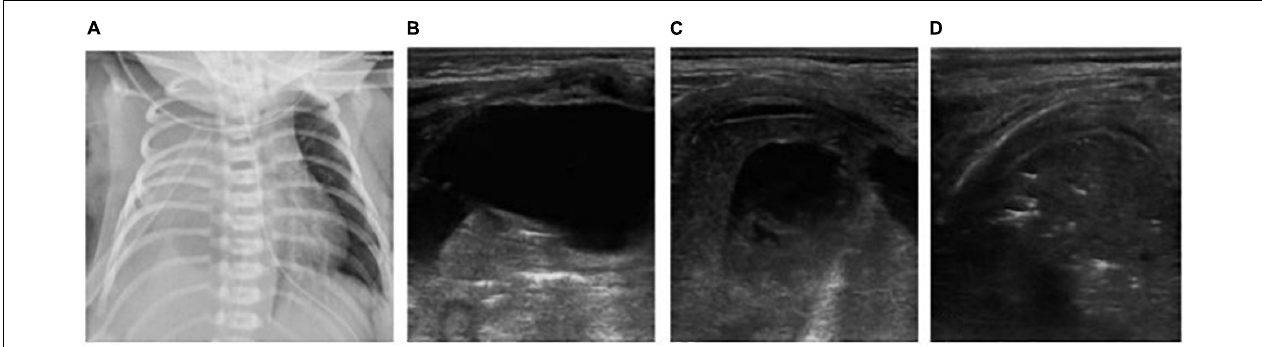
FIGURE 3 | The patient was born at 36 + 2 weeks of gestational age and diagnosed as congenital esophageal atresia. After surgical treatment, man-machine incongruity appeared under mechanical ventilation. X-ray shows white lung on the right lung (A) . Atelectasis? or pleural effusion? X-ray failed to distinguish. But LUS clearly showed a large amount of pleural effusion on the right side, the right lung was compressed, showing a liver like echo and the strip bronchial inflation sign, suggesting atelectasis of the right lung (B–D) . After thoracic puncture and drainage and adjustment of thoracic drainage tube, the right atelectasis